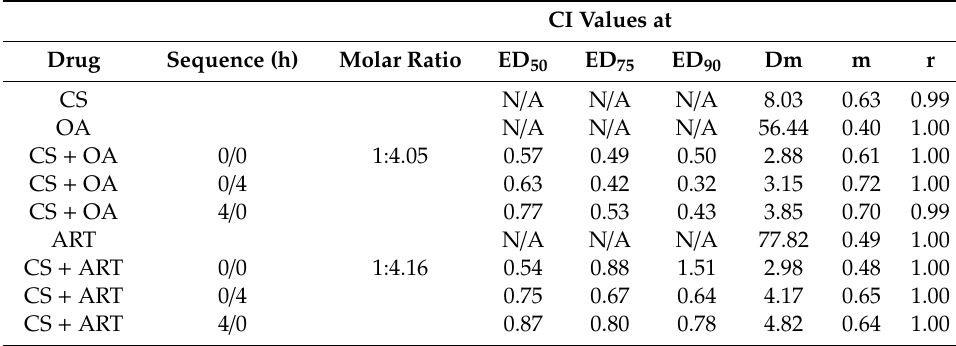
Table 3. CI values of CS with OA and ART in the A2780 cisR cell line where drugs were added in equipotent ratios based on IC 50 values.